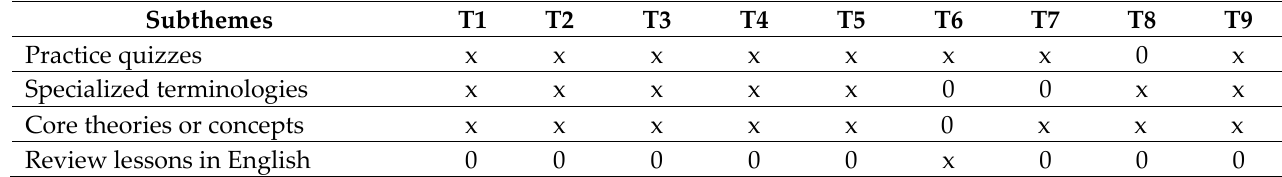
Table 6 . Input in EMI